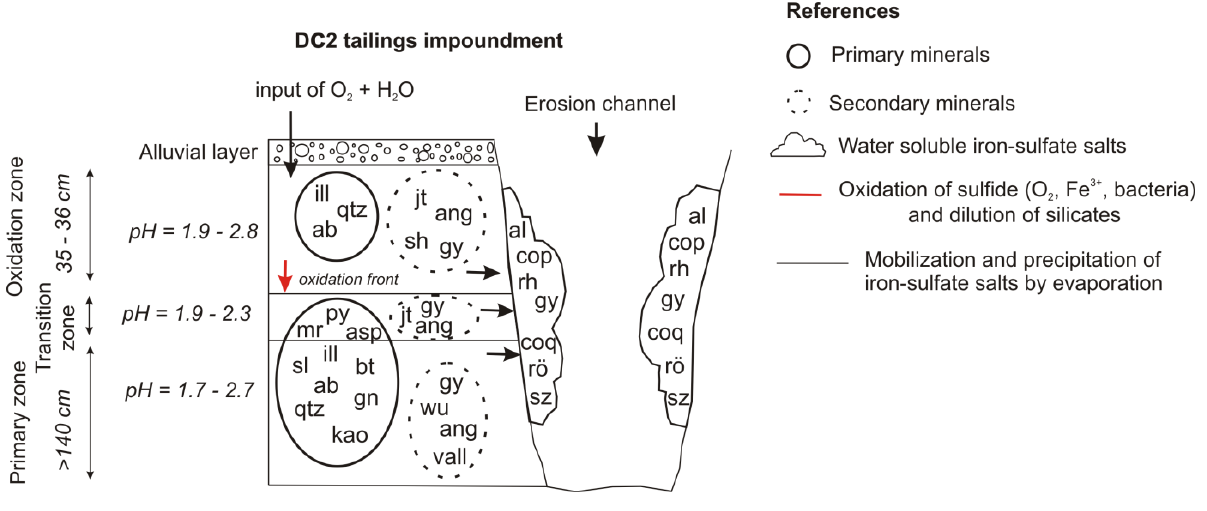
Figure 7. Scheme showing the main features, processes, and mineralogy of DC2 tailings impoundment. Abbreviations are gy = gypsum; jt = jarosite; qtz = quartz; ab = albite; ill = illite; kao = kaolinite; py = pyrite; mr = marcasite; sl = sphalerite; gn = galena; asp = arsenopyrite; wu = wupatkiite; vall = vallerite; al = alunogen, cop =